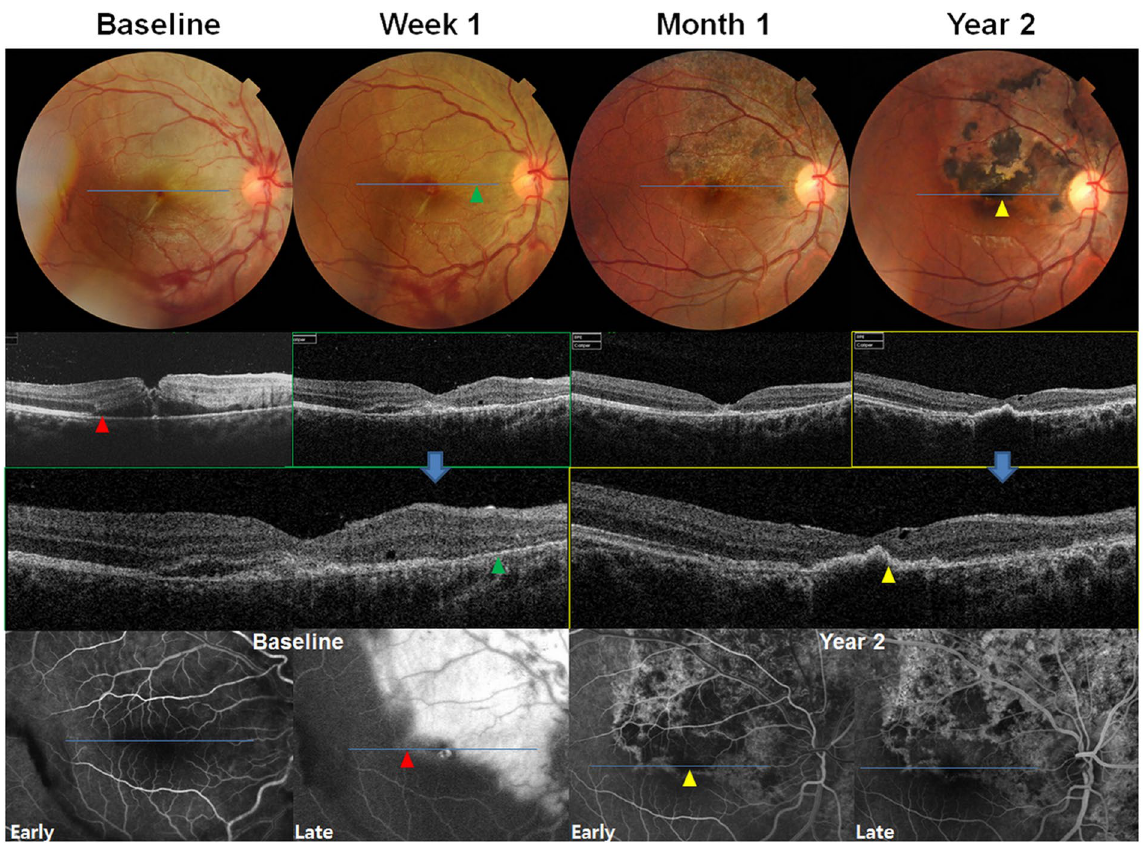
Figure 3. Fundus photographs (Top) and optical coherence tomography (OCT, middle) images showing microscopic structural changes in the eye with retinal pigment epithelium (RPE) sequelae. At baseline, a greyish or yellowish colour change is noted in the fundus photograph, and subretinal fluid (SRF) without definite vitreoretinal interface abnormality is noted on OCT. Fluorescein angiography (FA) images showing leakage and pooling at the late phase, which topographically corresponds to SRF (red arrowheads). At week 1, as SRF resolved in the nasal area to the fovea, a well-demarcated hypopigmentation (upper green arrowhead) corresponding to thinning of the RPE/Bruch’s membrane layer (lower green arrowhead) is noted in the OCT images. After 1 month, hyperpigmentation occurred within the hypopigmented lesion, which became prominent at year 2. Hyperpigmentation corresponds to a hyperreflective and thick RPE line (yellow arrowheads). FA images acquired at that time showing hypofluorescence on the hyperpigmentation and hyperfluorescence of the hypopigmented area, owing to blocked fluorescence and window defect, respectively. In both hypopigmented and hyperpigmented lesions, complete photoreceptor loss is commonly observed in the OCT